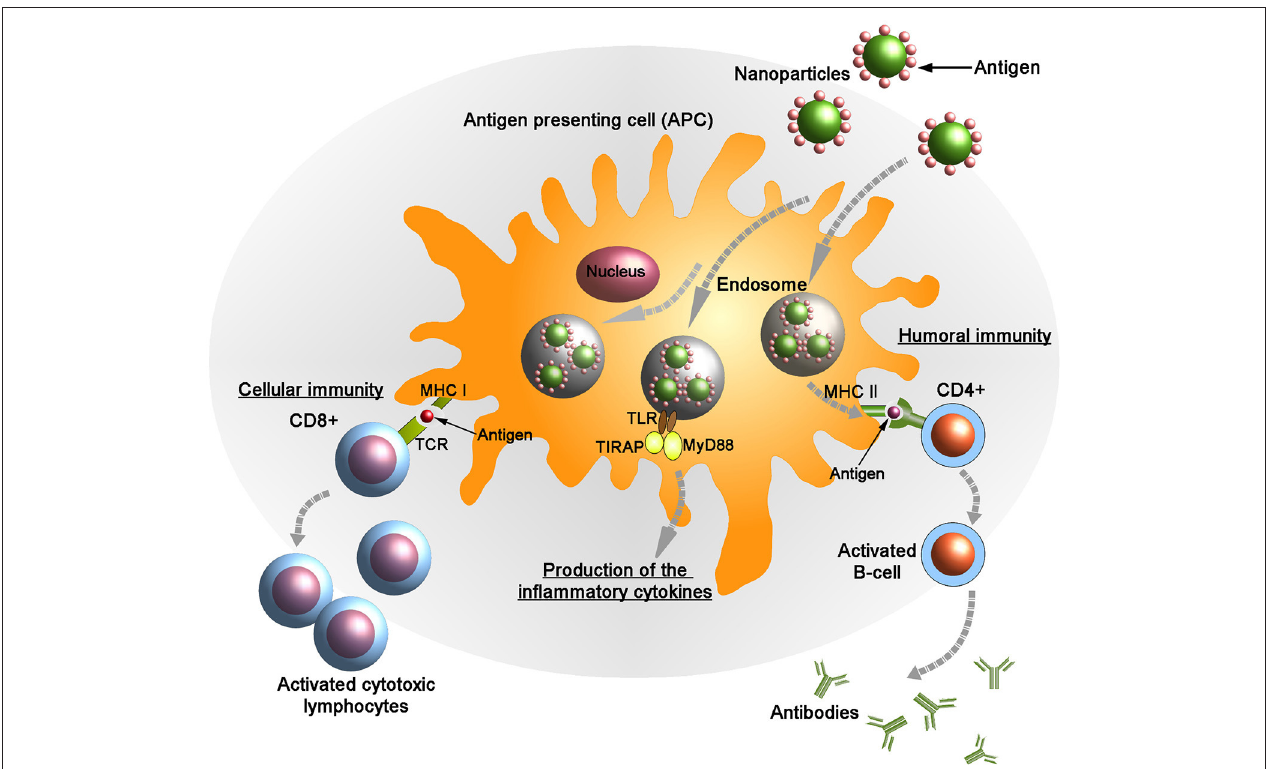
FIGURE 2 | Targeted delivery of antigenic molecules using surface engineered nanoparticles into the antigen presenting cells (APCs). Endogenously generated antigens are presented in complex with class I major histocompatibility complex (MHC I) on the membrane of APCs to CD8 + T lymphocytes. Following the interaction between MHC I and T-cell receptor (TCR) in presence of co-stimulatory molecules and cytokines the activated CD8 + cells kill the infected cells by inducing cytotoxicity. Also the antigens are presented on the APC surface by class II MHC molecules to the helper (CD4 + ) T cells. Subsequently, CD4 + cells activate B-cells that produce anti-microbial antibodies. Upon stimulation the adaptor proteins MyD88 (myeloid differentiation marker 88) and TIRAP (TIR domain containing adaptor protein) colocalize with TLR (toll-like receptor) allowing for activation of the NF- κ B pathway and leading to the production of pro-inflammatory